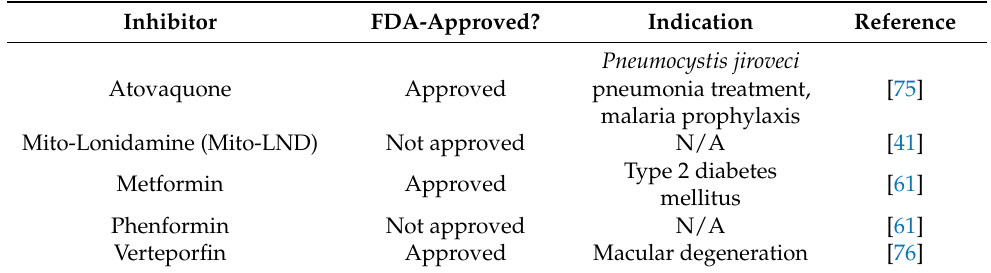
Table 2. Inhibitors of oxidative phosphorylation (OXPHOS) to selectively target glioblastoma stem cells